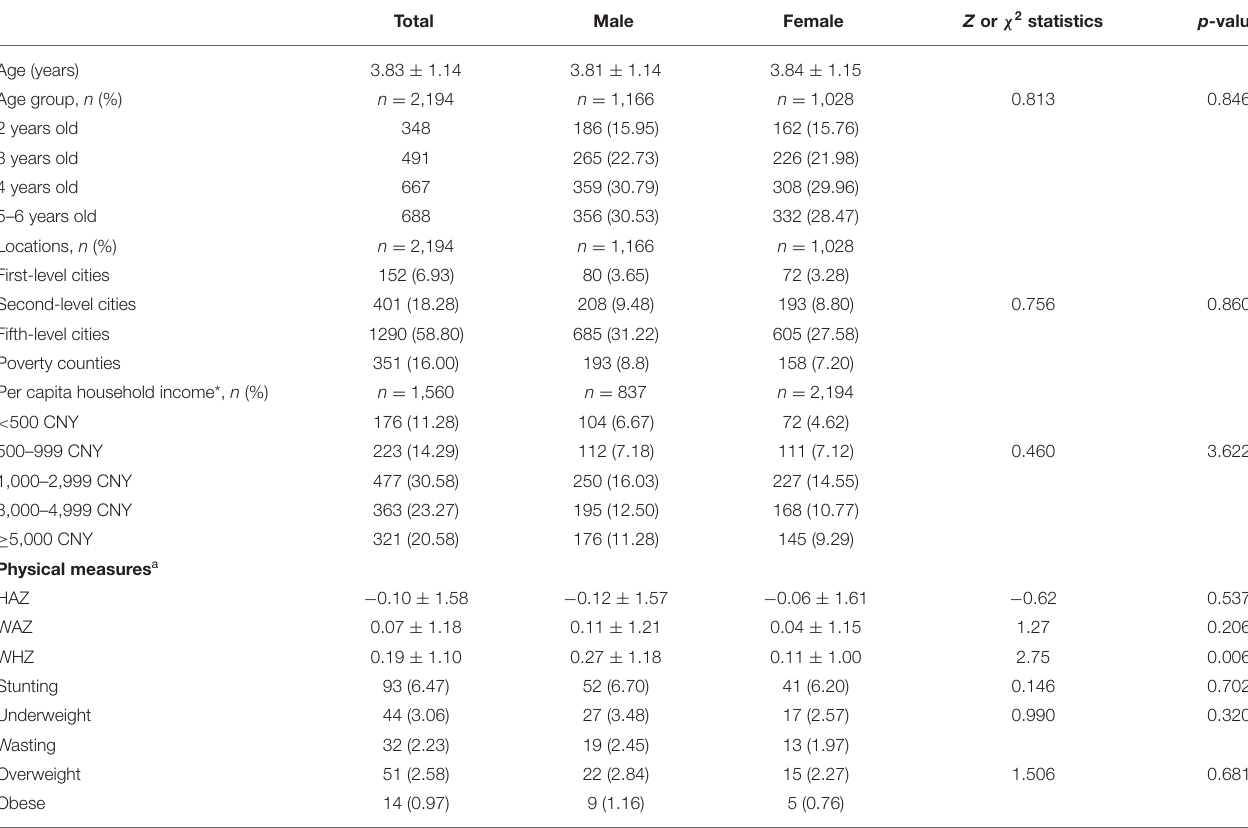
TABLE 1 | Basic demographic and physical characteristics of